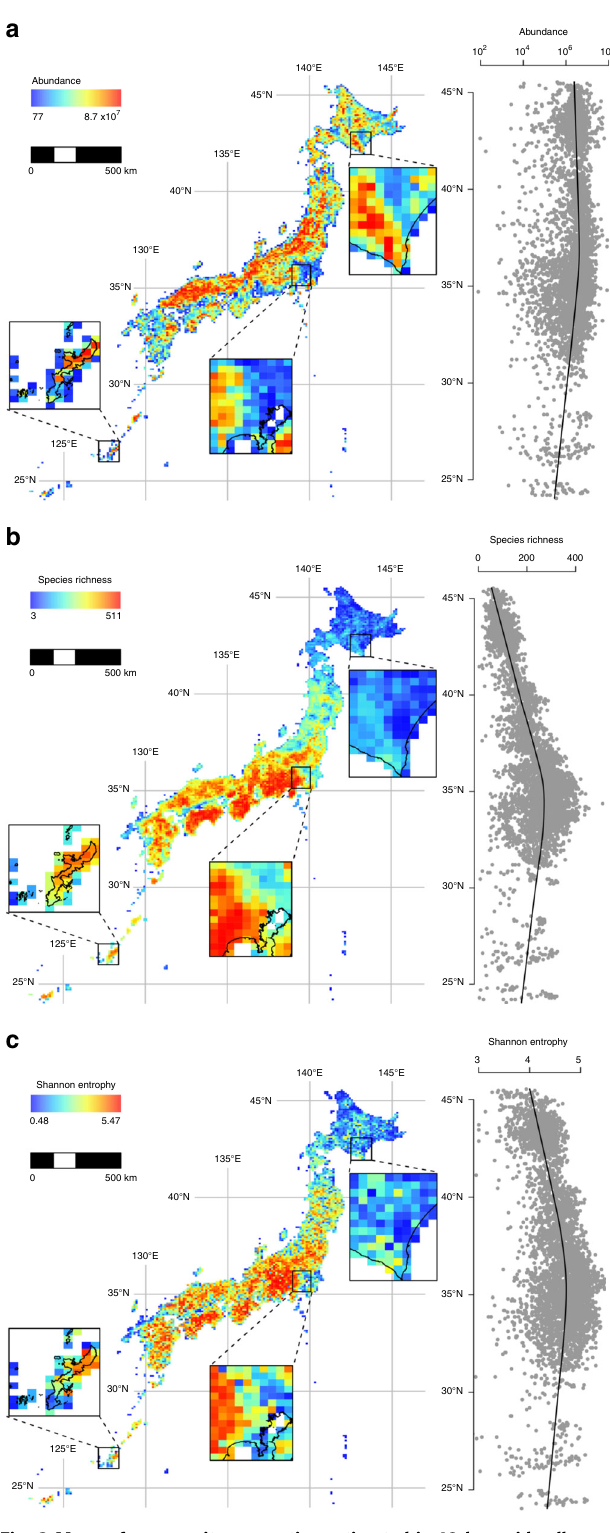
Fig. 2 Maps of community properties estimated in 10-km grid cells. a Total number of individuals (abundance), b number of species (species richness) and c species diversity index (Shannon entropy). To illustrate fi ner spatial patterns, three arbitrarily selected sections are enlarged. The marginal plots indicate estimated values in each grid cell along latitude, with a fi tted line obtained using a lowess smoother. A scatter plot matrix for these three variables is provided in Supplementary Fig. 6. Maps of standard errors of these three variables are provided in Supplementary Fig.